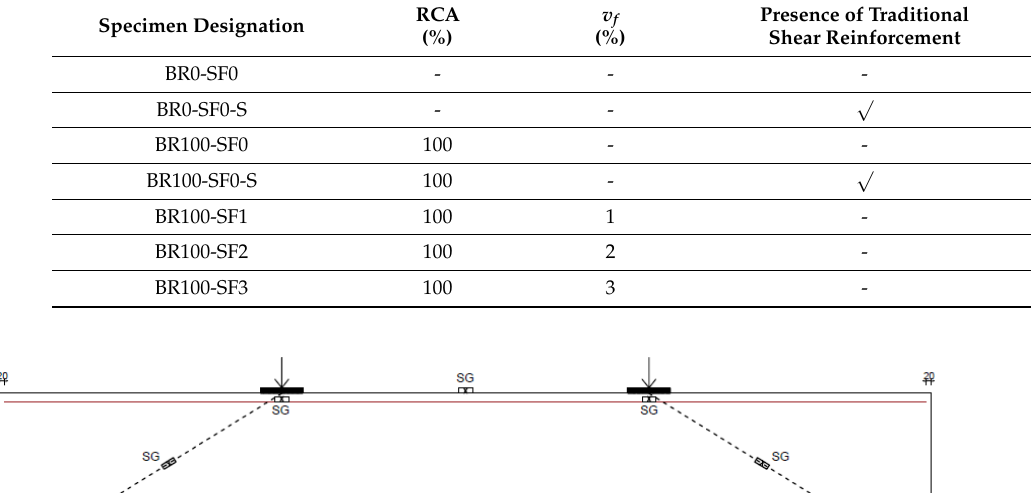
Table 4. Test matrix of the deep beam specimens.